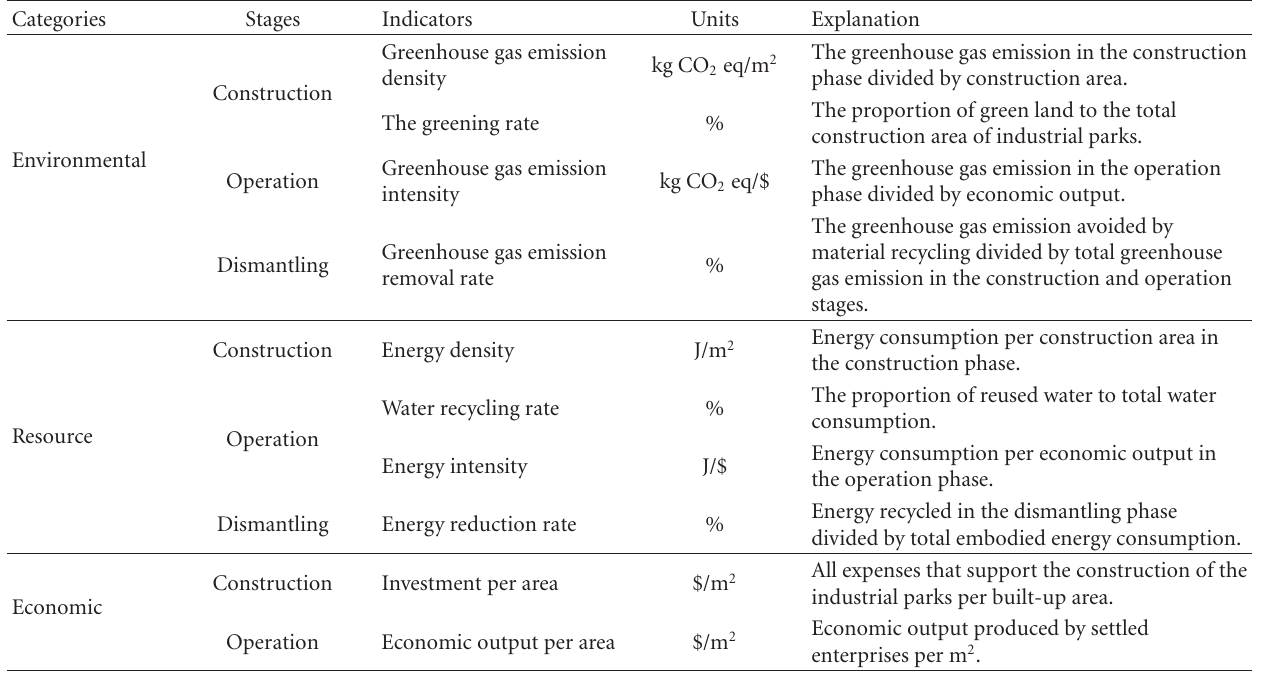
Table 1: Sustainability evaluation indicators in the multicriteria